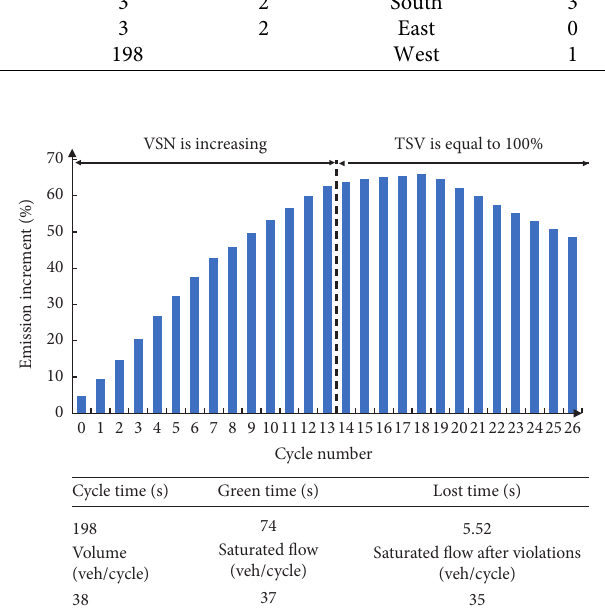
Figure 12: Emission increment after violations such as cycle passing (volume � 38 veh/lane/cycle).